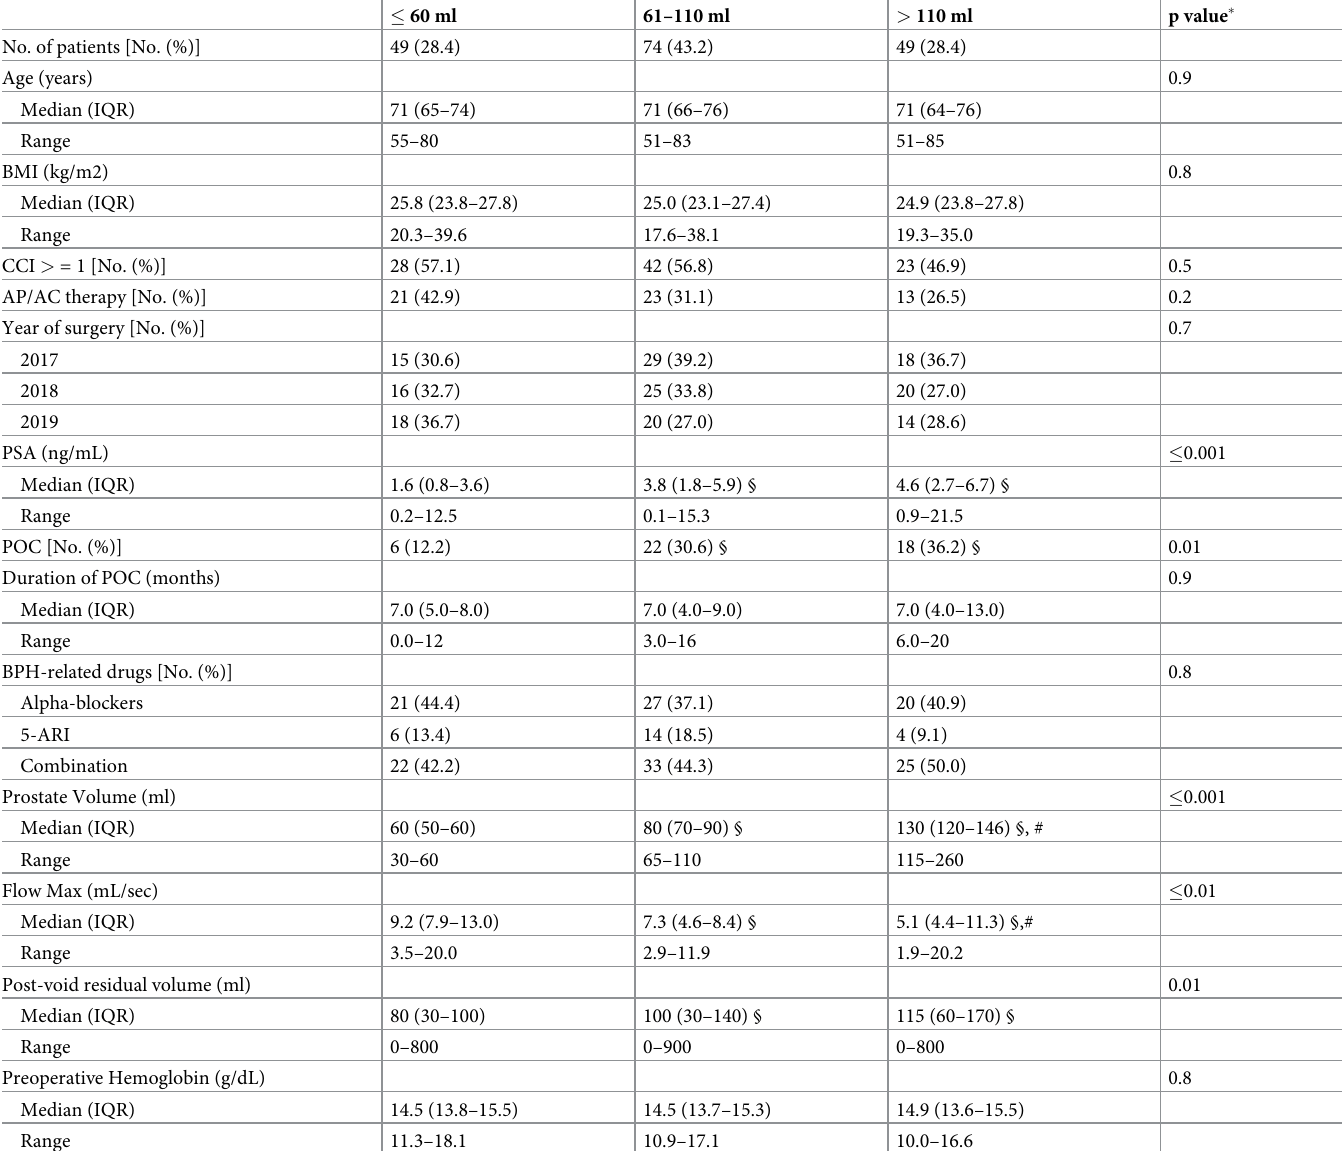
Table 1. Preoperative characteristics of the whole cohort of patients submitted to B-TUEP as segregated according to prostate volume (no. = 172). � 60